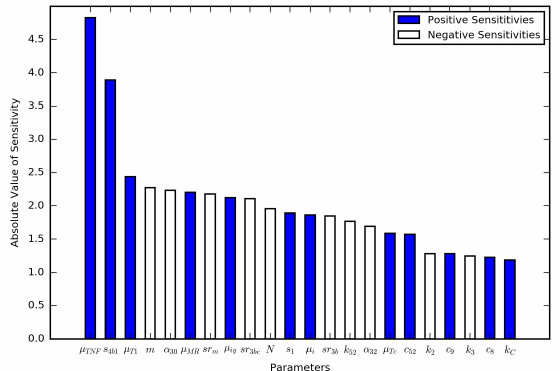
Figure 5. Local sensitivity analysis results for the parameters from the immune response model that were at least as sensitive as the new model parameter k C